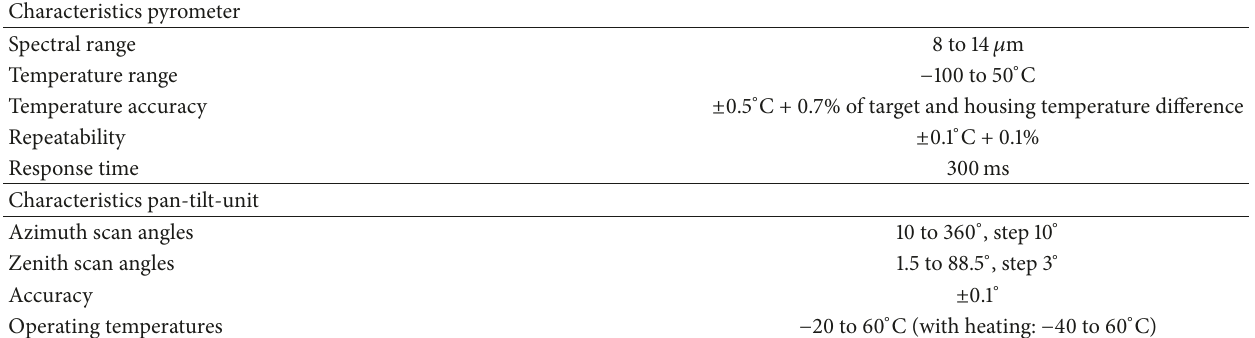
Table 1: Technical characteristics of the NubiScope [8].